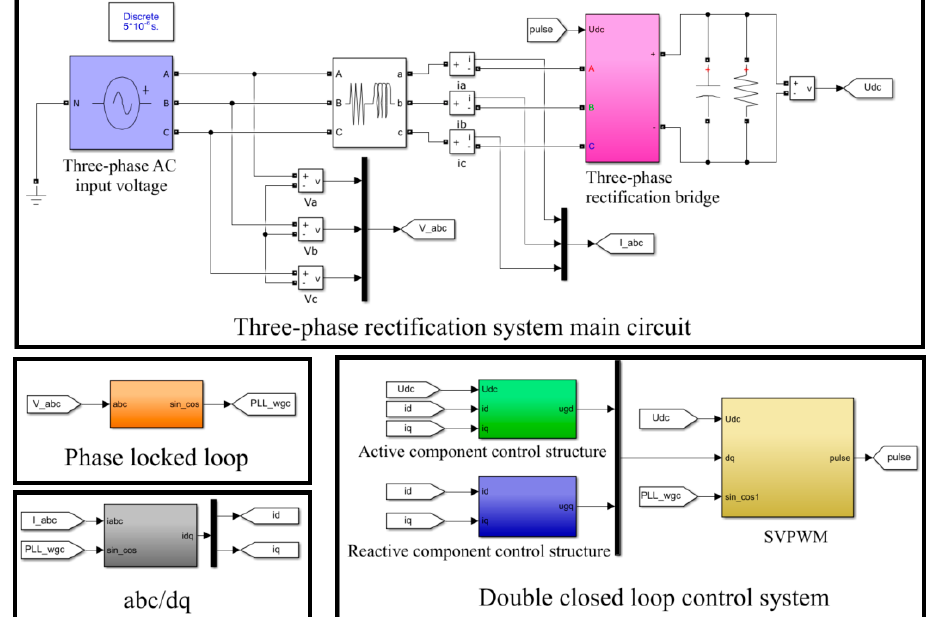
Table 1. Simulation circuit parameters.